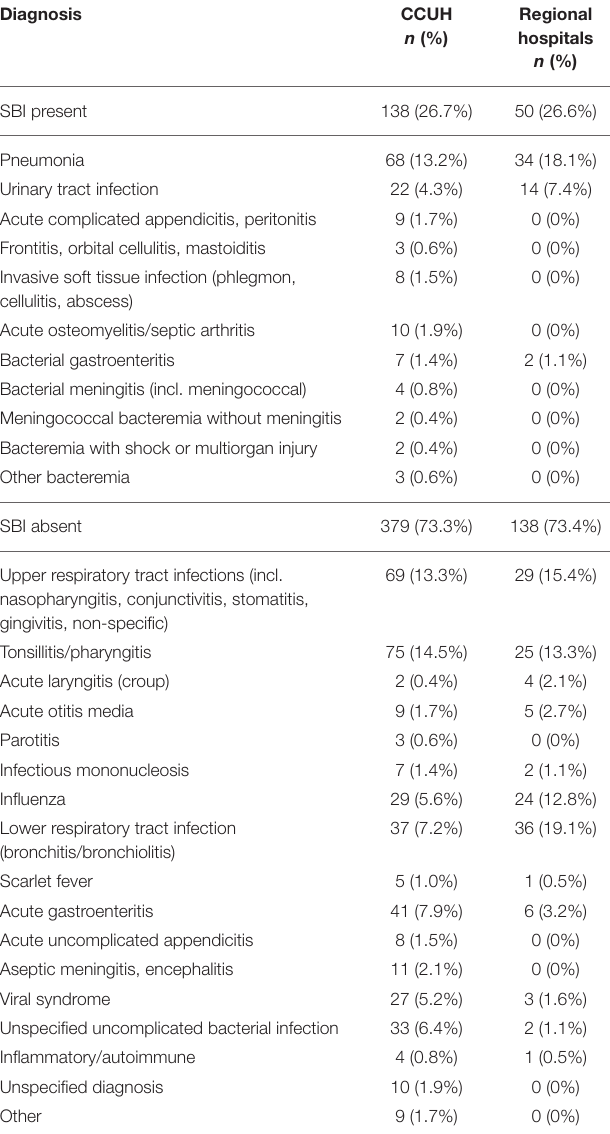
TABLE 2 | Final diagnoses in derivation cohort (CCUH) and validation cohort (regional